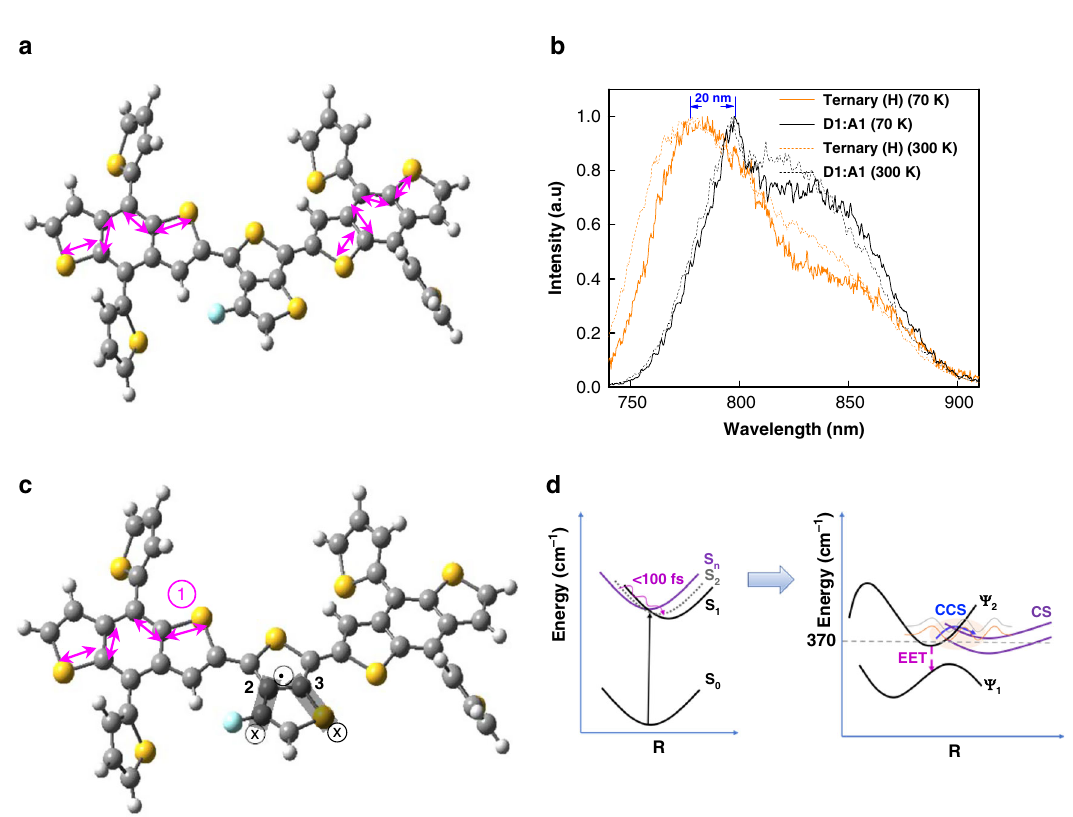
Fig. 4 Coherent kinetic process. a The in-plane breathing mode. The initial excitation delocalized by the in-plane breathing mode. Vibration direction indicated by arrow. b The transient photoluminescence peak of the Ternary (H) demonstrates a blue shift compared to the D 1: A 1 blend at the fi rst 20 ps timescale. c Out-of-plane mode (gray shadow). For the 200 cm − 1 vibration mode, mainly due to the out-of-plane vibration of 3- fl uorothieno[3,4-b] thiophene by the C 2 and C 3 bond. The in-plane breathing mode of the benzo[1,2-b;4,5-b ′ ]dithiophene ① simultaneously with the out-of-plane vibration of 3- fl uorothieno[3,4-b]thiophene, aid in charge separation simultaneously during the fi rst 200 fs. Vibration direction indicated by arrow. d Kinetic approach for excitation energy transfer (EET) and coherent charge separation (CCS) process. Here, the resulting charge separated states (CS) are delocalized. Potential energy surfaces sections (PES) de fi ned by the electronic wavefunctions ( Ψ 1 , Ψ 2 ) of the excited states as a function of torsional, ring-breathing and intra/ intermolecular bond stretching coordinates(R). The gray and pink line represent the EX and CS vibronic wavefunction, extended on both